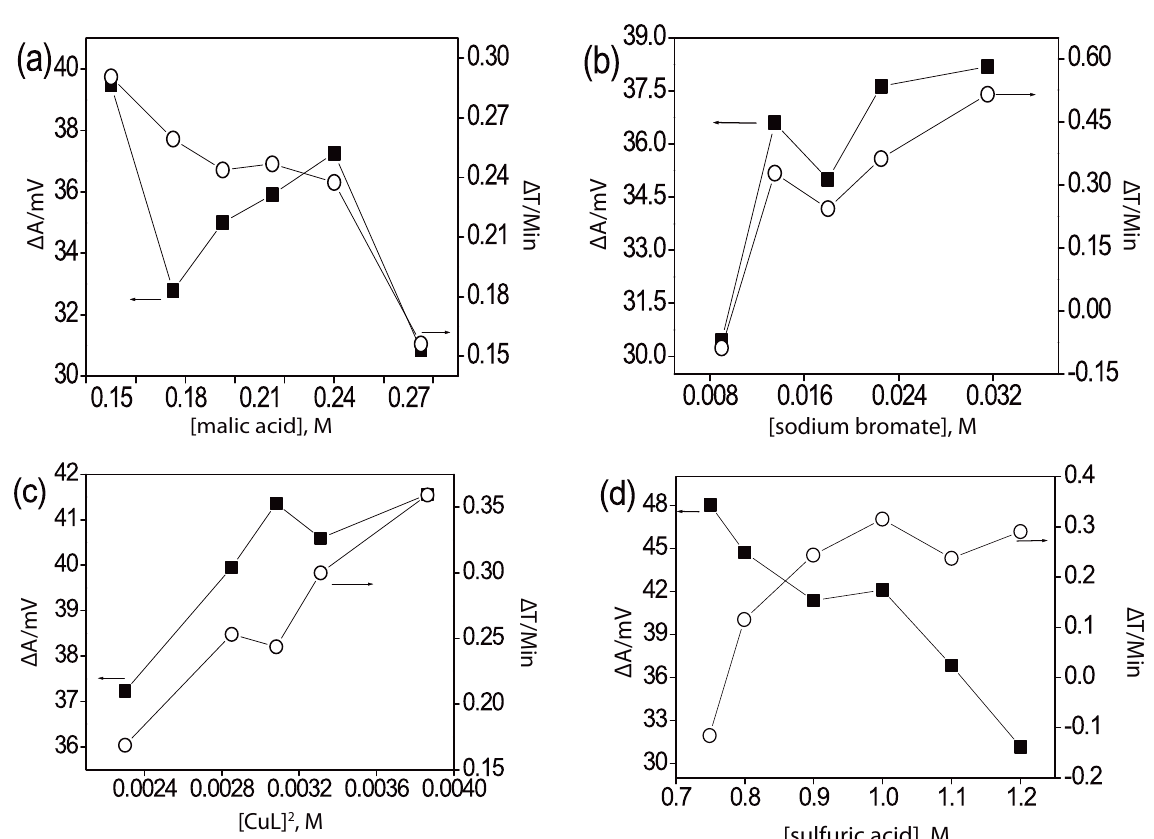
Figure 2. Influence of the concentrations of (a) malic acid; (b) Sodium bromate; (c) [CuL](ClO oscillation system ( ■ refers to Δ Amplitude and ○ refers to Δ Period ) Conditions: (a) [ [CuL](ClO ) ] = 3.08 × 10 -3 M, [Sodium bromate] = 0.018 M , [Sulfuric acid ] = 0.9 M, [Alizarin Red S] = 5 × 10 -6 M. 4 2 (b) [